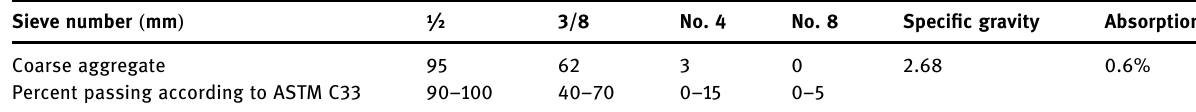
Table 3: The sieve analysis and physical properties of coarse aggregates Sieve number ( mm ) ½ Coarse aggregate Percent passing according to ASTM C33